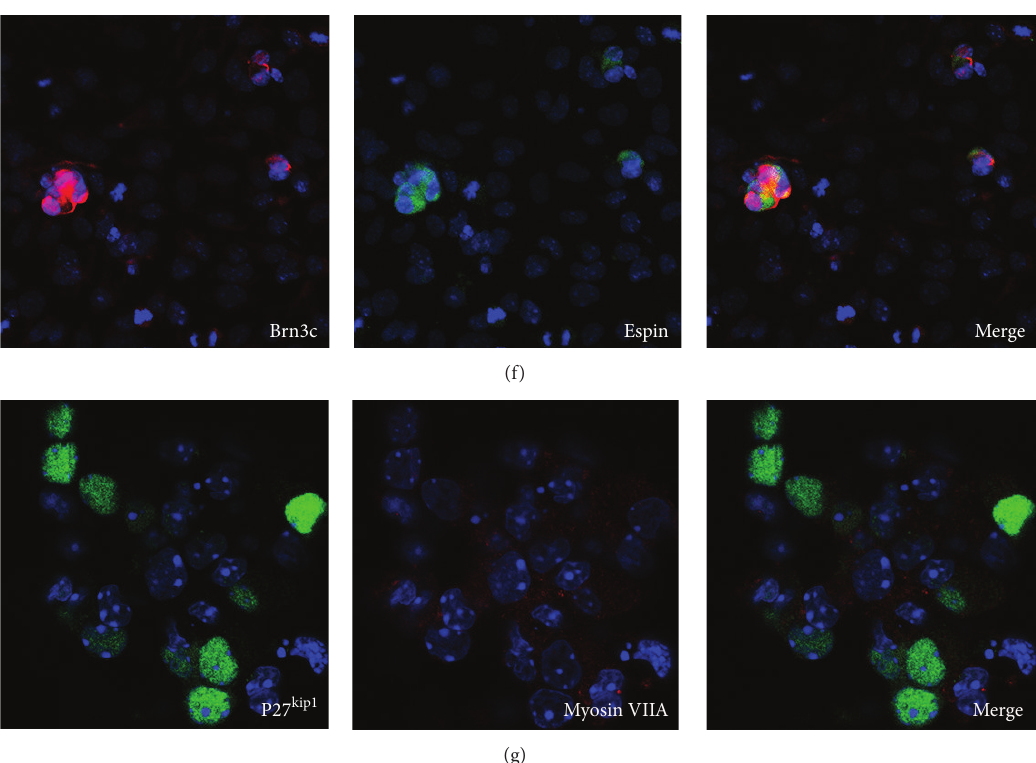
Figure 3: Molecular characterization of inner ear multipotent cells and derived cells differentiating on poly-L-lysine substratum. (a) RT-PCR analysis of the expression of markers specific for hair cells and supporting cells. The ubiquitously expressed GAPDH is shown as reference. (b) Expression of markers specific for hair cells and supporting cells: Myosin VIIA, Brn3c, Espin, and P 27 kip 1 . Spheres: spheres generated from innerearmultipotentcells,7 d:cellsdifferentiatedfor7daysonthepoly-L-lysinesubstratum invitro ,and14 d:cellsdifferentiatedfor14dayson the poly-L-lysine substratum in vitro (as shown in Figure 2(a)). Statistically significant differences between groups are indicated by ∗ 𝑃 < 0.05 , ∗∗ 𝑃 < 0.01 , and ∗∗∗ 𝑃 < 0.001 ( 𝑛 = 3 ). (c) After 5 days of differentiation, Atoh1-positive cells appeared in differentiating sphere-derived cells (red, left). After 2 weeks of differentiation (as shown in Figure 2(a)), hair-cell-like cells appeared in cells derived from spheres. 25 ± 3.1 % ( 𝑛 = 5 ) of differentiated cells were labeled with an antibody to Myosin VIIA (green, center), and 18 ± 3.7 % ( 𝑛 = 5 ) of differentiated cells were labeled with an antibody to Espin (green, right). Nuclei were visualized with DAPI. (d) All cells immunopositive for Myosin VIIA also expressed Atoh1. (e) Myosin VIIA-positive cells in stem-cell-derived cell populations coexpressed the stereocilia marker Espin. (f) The Espin- positive cells in stem-cell-derived cell populations coexpressed Brn3c. (g) Conventional fluorescence microscopy showing nonoverlapping expression of p 27 kip 1 (green) and Myosin VIIA (red) in differentiated cells.